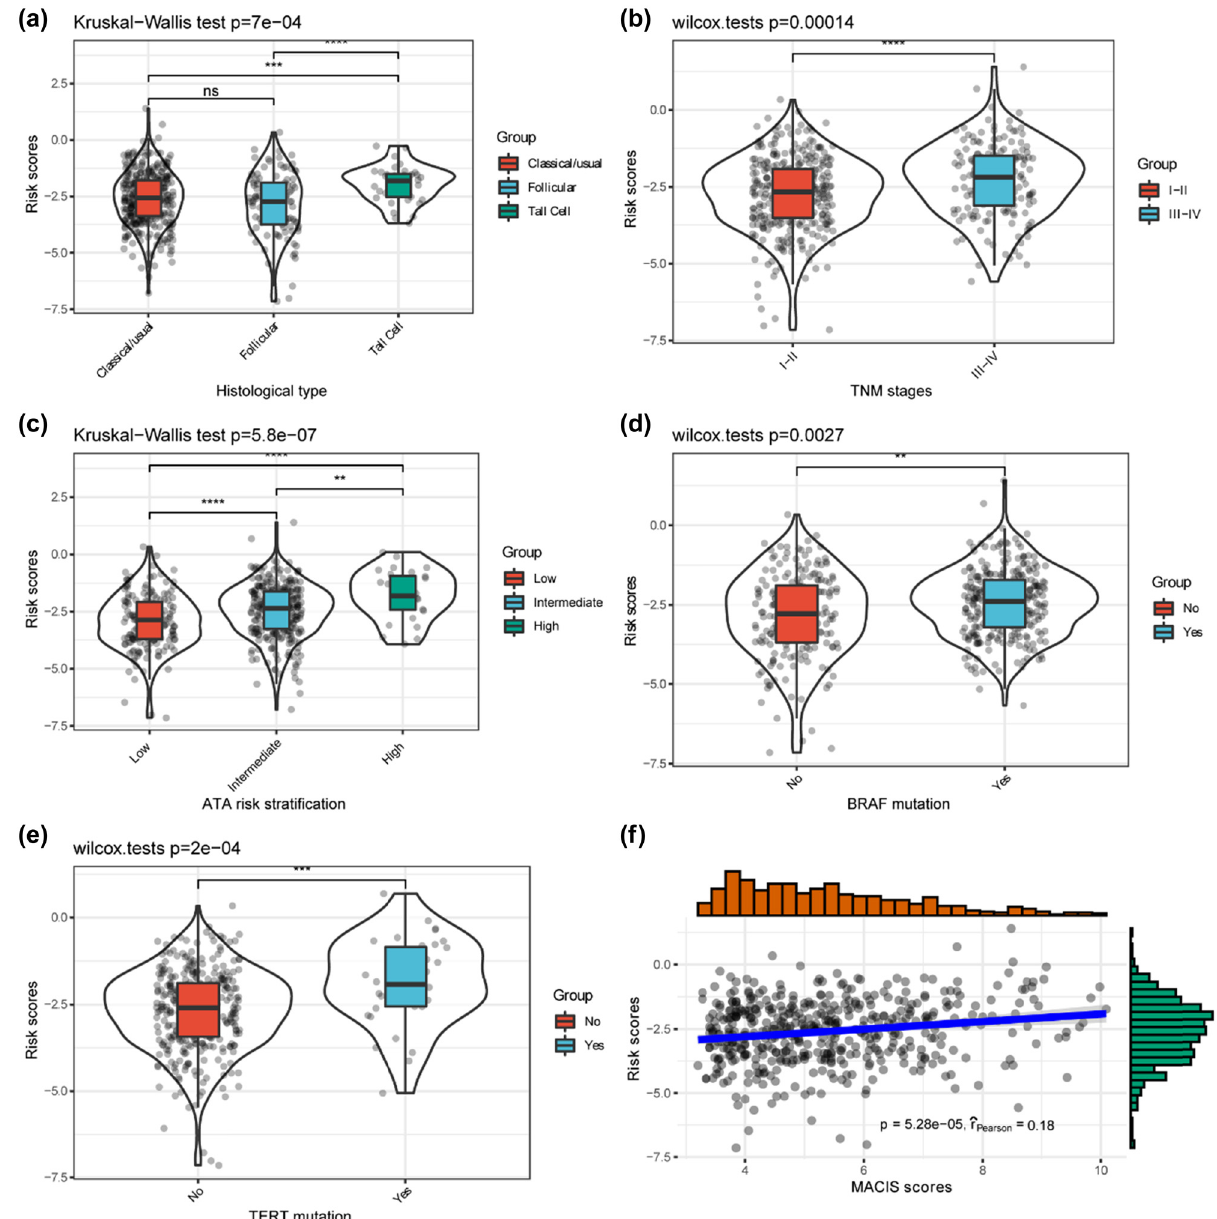
Figure 8: Comparison of the risk scores in patients with di ff erent features. ( a ) Comparison of the risk scores in patients with di ff erent histological types. ( b ) Comparison of the risk scores in patients with di ff erent TNM stages. ( c ) Comparison of the risk scores in patients with di ff erent ATA risk strati fi cation. ( d ) Comparison ofthe risk scores in patients withor without BRAFmutation. ( e ) Comparisonof therisk scores in patientswith orwithout TERT mutation ( f ) Correlation of the risk scores and MACIS scores. Note: ns, not signi fi cant; **, P < 0.01; ***, P < 0.001; ****, P <